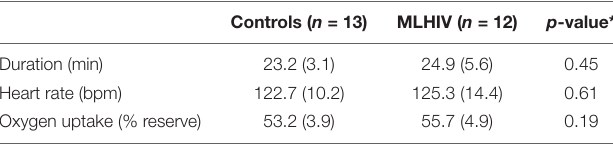
TABLE 2 | Characteristics of submaximal exercise session in controls and men living with HIV